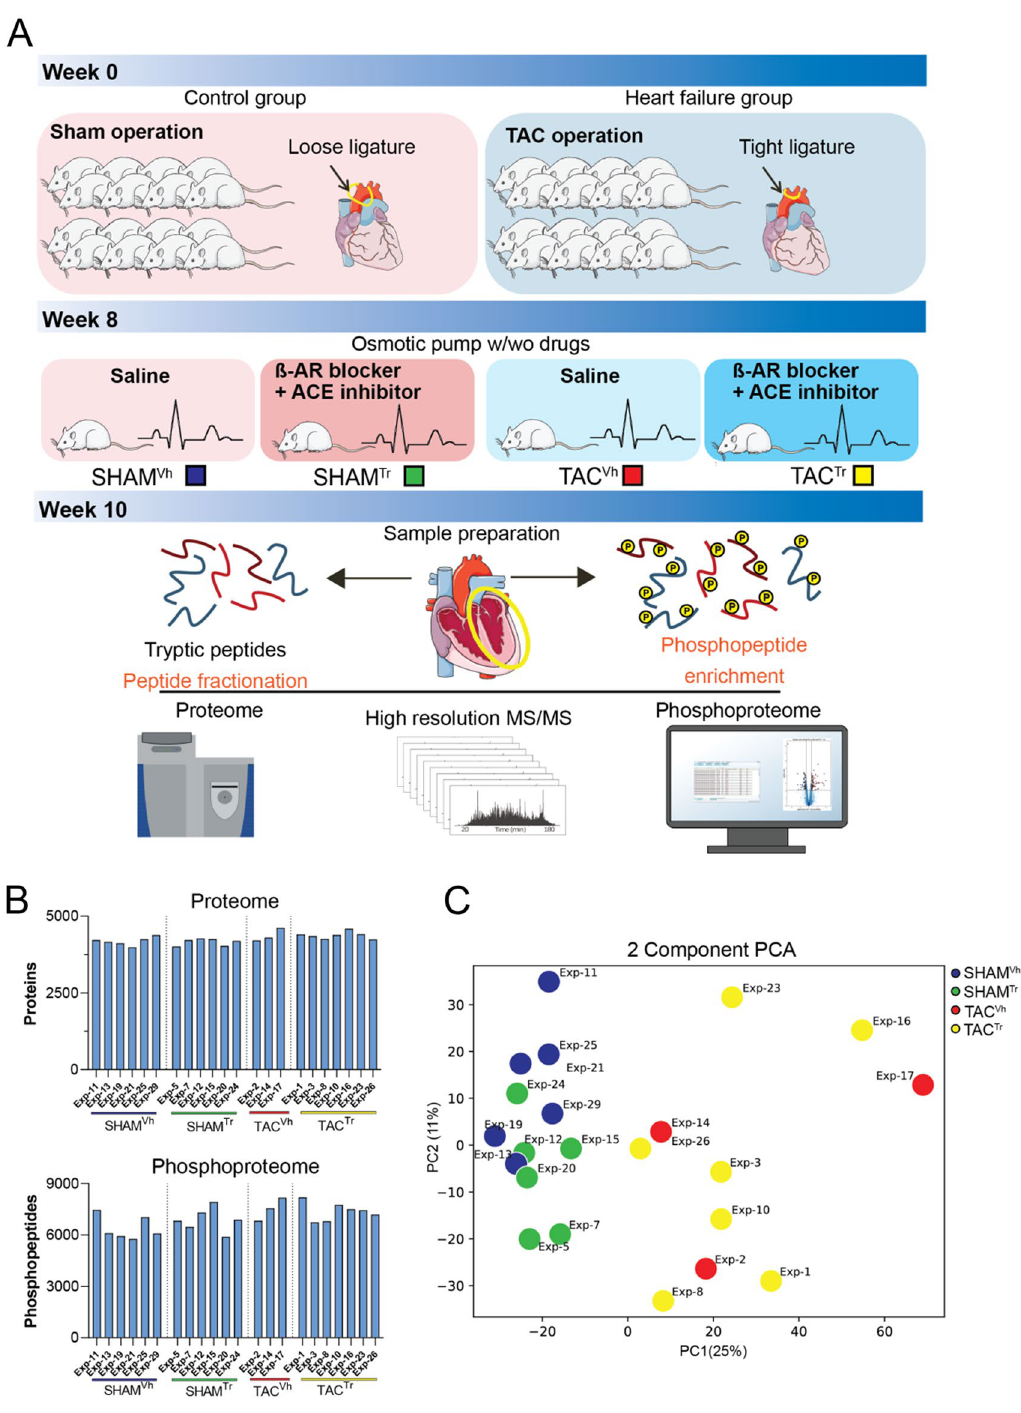
Figure 1. Experimental design and proteomics workflow. ( A ) Mice received either a loose ligature around the aorta (SHAM) or a tight ligature (TAC). Eight weeks post-surgery, cardiac function was evaluated by echocardiography and osmotic pumps delivering either saline (SHAM Vh or TAC Vh ) or ß-AR blocker and ACE inhibitor (SHAM Tr and TAC Tr ) were implanted. Ten weeks post-surgery, cardiac function was again evaluated by echocardiography, mice were sacrificed, hearts explanted, and the left ventricle dissected. Proteins were extracted from left ventricular tissues and subjected to deep proteome and phosphoproteome measurements by LC–MS/MS analysis. Heart and animal illustrations have been downloaded and modified from the open source Servier Medical Art (smart.servier.com) ( B ) Bar graphs summarizing the number of proteins (top) and phosphorylated peptides (bottom) measured for each heart sample. ( C ) Principal component analysis of measured protein intensities for all analyzed heart samples. Data from the four animal groups are illustrated by colors: data from animals in the SHAM Vh group are depicted in blue, SHAM Tr in green, TAC Vh in red and TAC Tr in